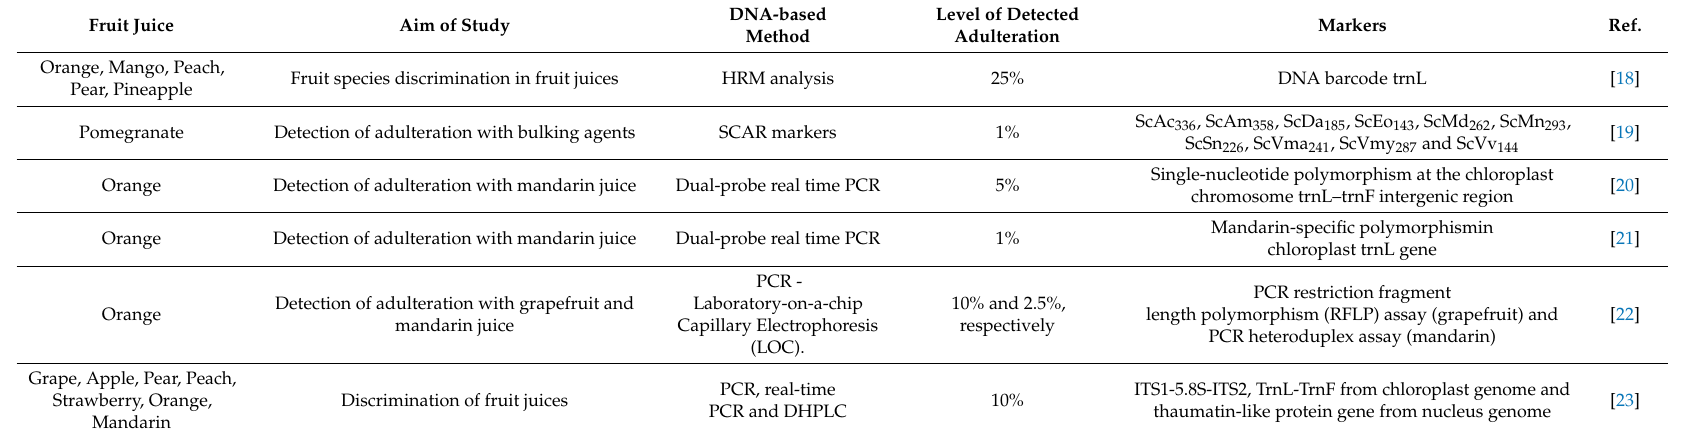
Table 1. Applications of DNA-based techniques in authenticity studies of fruit